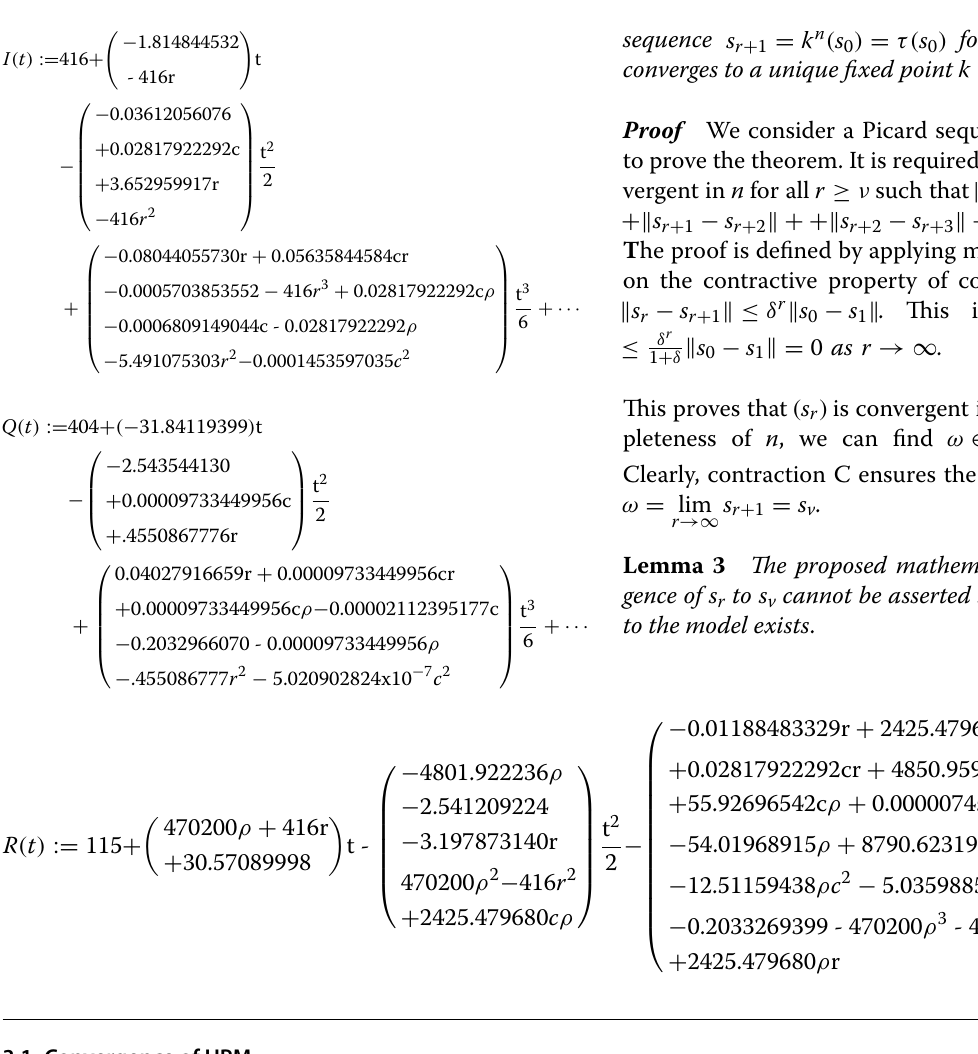
Table 5 Error range of each class at t ∈ [ 0,1